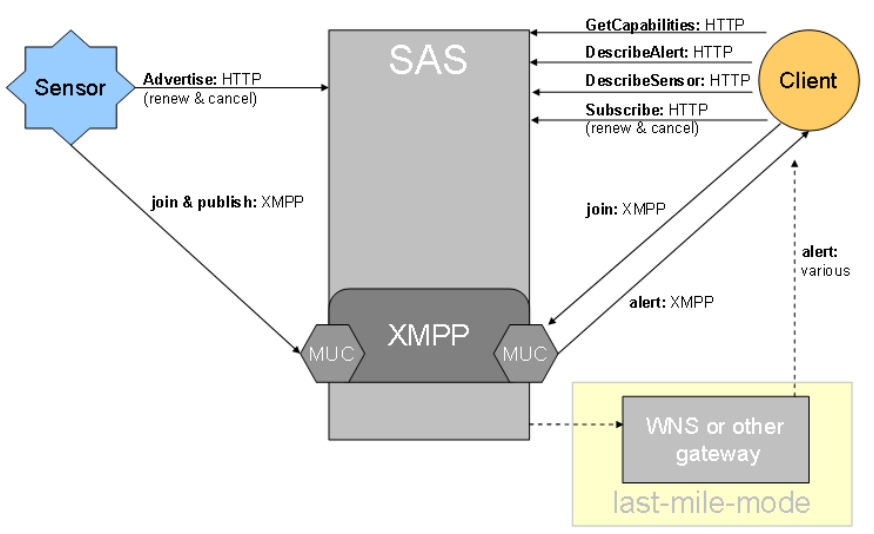
Figure 3. General SAS Functionality